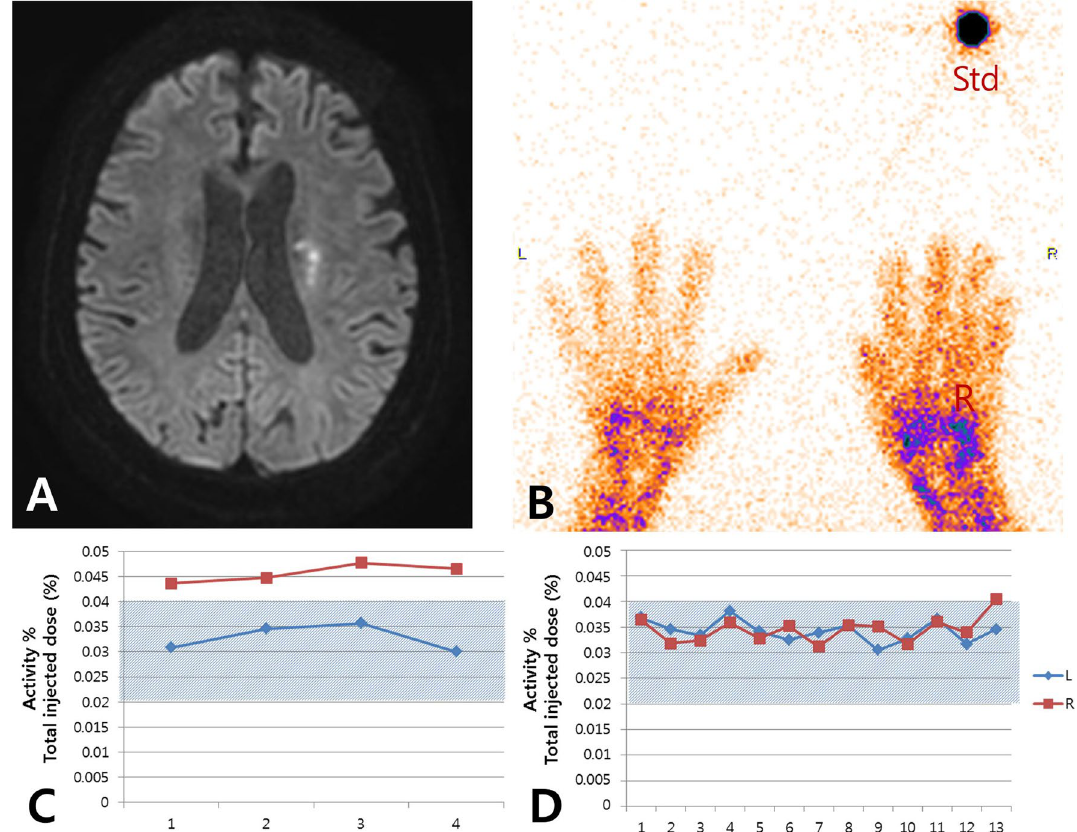
Figure 1. Modified Raynaud scan of preserved vasoreactivity case. ( A ) High signal intensity in left periventricular white matter on the diffusion-weighted image. ( B ) Scan for both hands and standard source. ( C ) Congested right fingertips in resting state. Activity % of the total injected dose means the percentage of total blood. ( D ) Preserved vasoreactivity under thermal stress. The amount of blood in the right hand became equal to the amount in the left hand, and the pattern was stable during the scan. The shaded area in ( C , D ) represents the reference range obtained from 10 normal volunteers. R: right; L: left; Std: